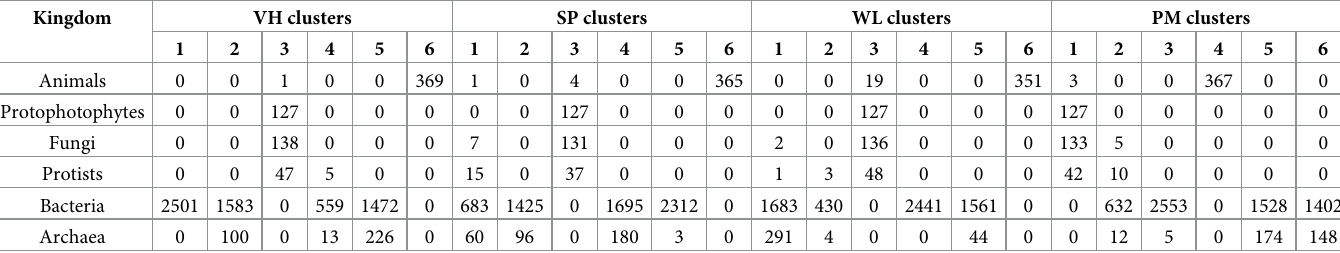
Table 1. Whole dataset experiment, kingdom level: Clustering results for kernels VH, SP, WL and PM starting from the MDS data. Kingdom VH clusters SP clusters WL clusters Animals Fungi Protists Bacteria